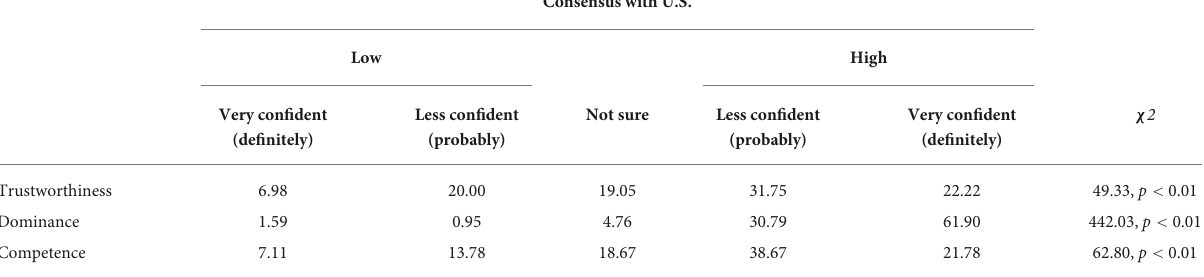
TABLE 2 Japanese adults’ impression judgment (choice rate; %) and the result of the chi-squared-test in Experiment 2. Consensus with